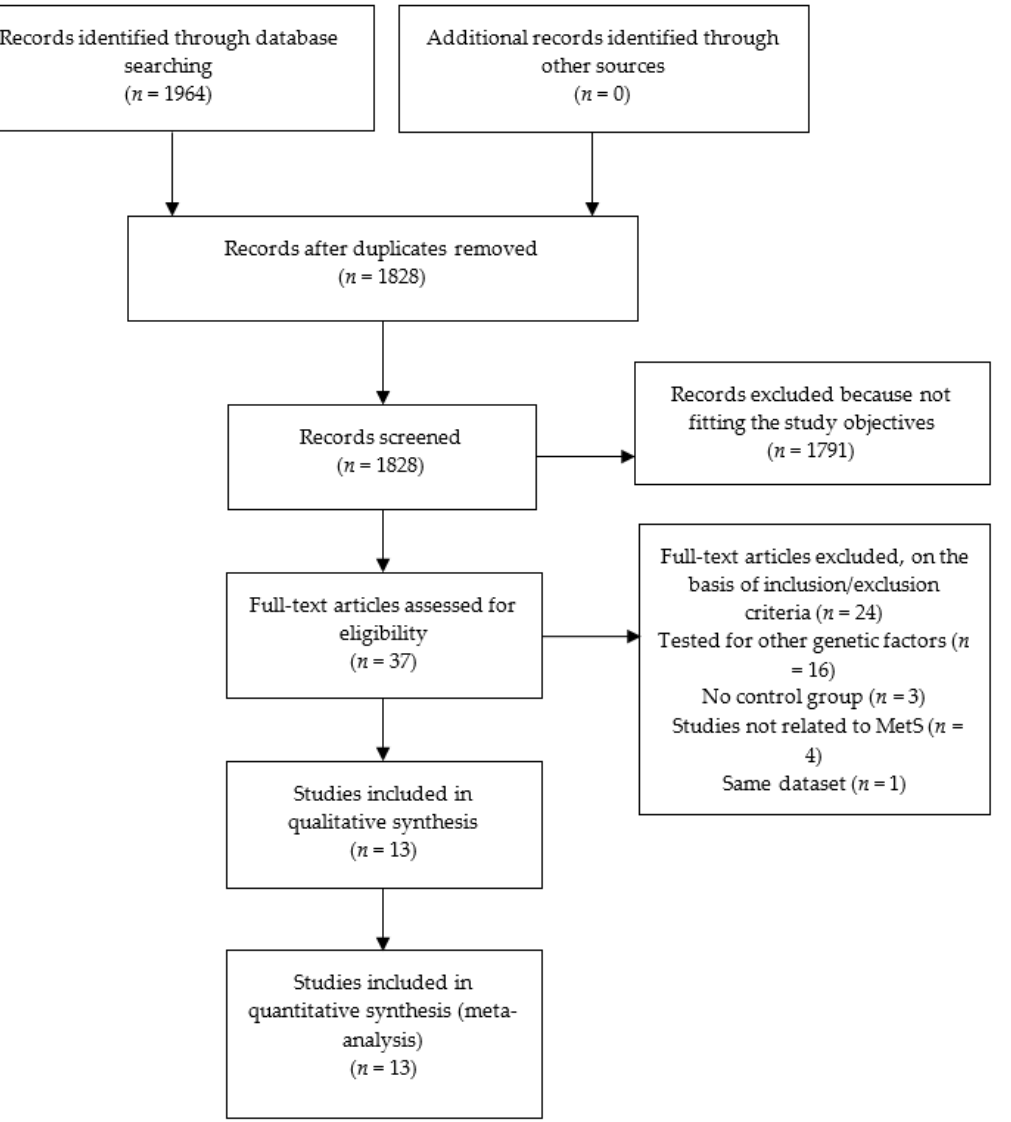
Figure 1. Flowchart of the systematic review on metabolic syndrome.